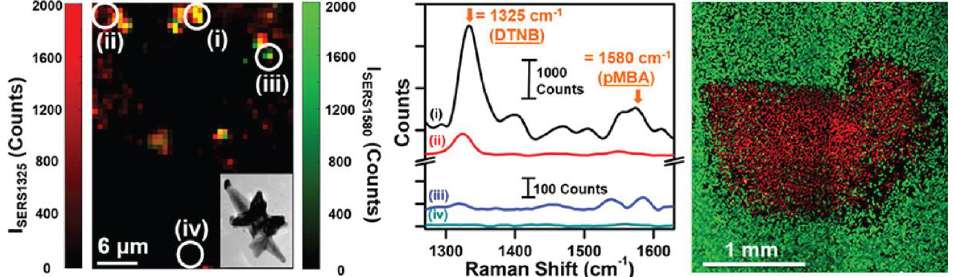
Figure 5. ( Left ) Raman intensity plot of I SERS1325 and I SERS1580 obtained from multiplex imaging of MDA-MB-231 TNBC cells using multibranched gold nanoantennae (inset) showing signals from (i) both probes, (ii) DTNB alone, (iii) 4-MBA alone, and (iv) no signal; ( middle ) the Raman spectra obtained from (i) both probes, (ii) DTNB only, (iii) 4-MBA only, and (iv) no probes or intracellular lipids; and ( right ) live cells (green) and dead cells (red) observed via confocal fluorescence imaging after photothermal cell death. Reprinted with permission from Ref. [92]. Copyright 2017 American Chemical